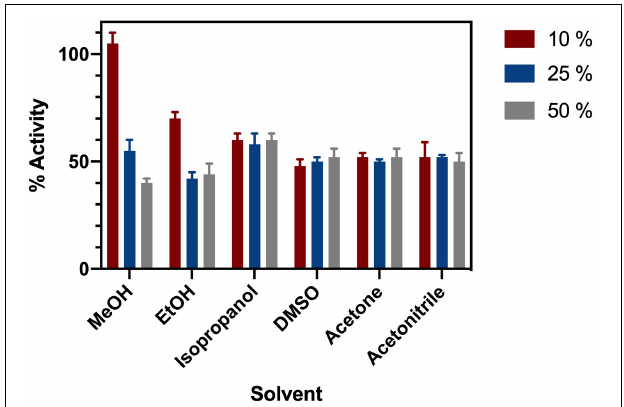
FIGURE 3 | Solvent Stability of ChTK-F. The percentage of relative enzyme activity for ChTK-F after incubation for 1 h in buffer and with 10% (Black Bar),